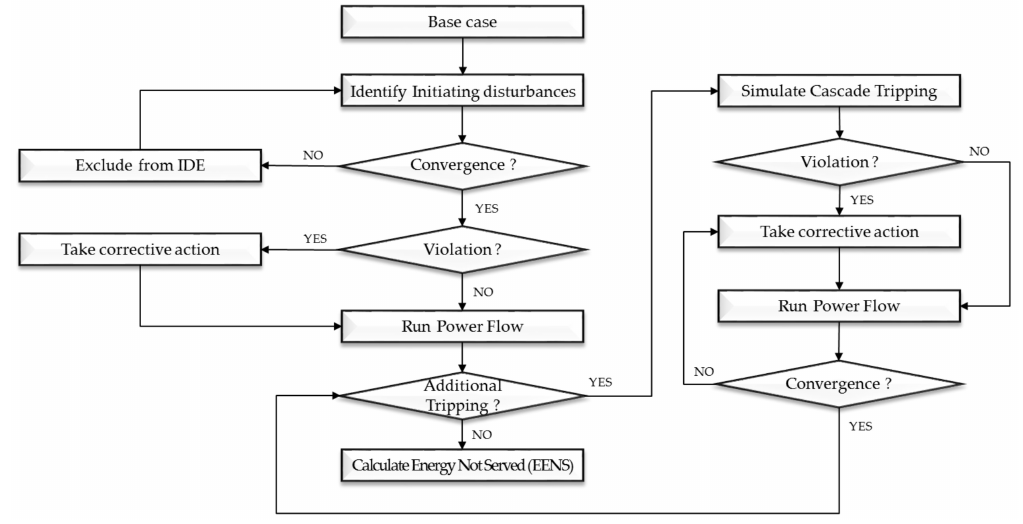
Figure 2. Sequence of the screening methodology for estimating Expected Energy Not Served